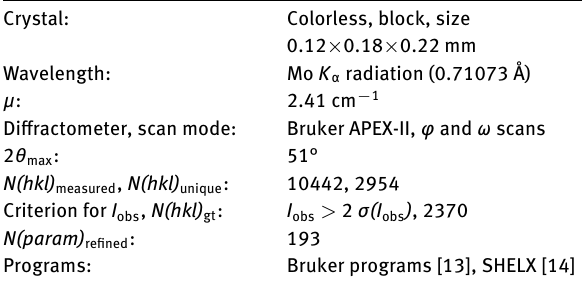
added to the solution in batches under stirring.